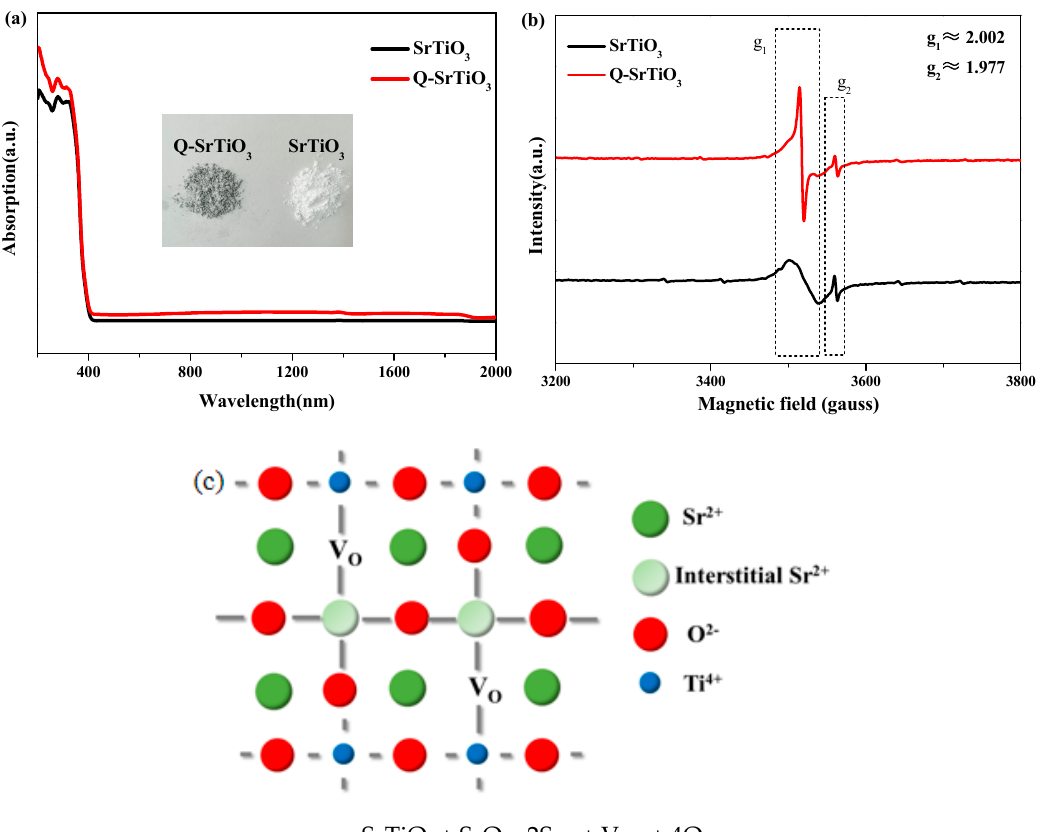
Figure 2. UV-vis absorption spectra of SrTiO 3 and Q-SrTiO 3 ( a ), the insert is a photograph of SrTiO 3 and Q-SrTiO 3 ; EPR spectra of SrTiO 3 and Q-SrTiO 3 ( b ). Schematic illustration of lattice change of Q-SrTiO 3 after solvent-quenching ( c ).